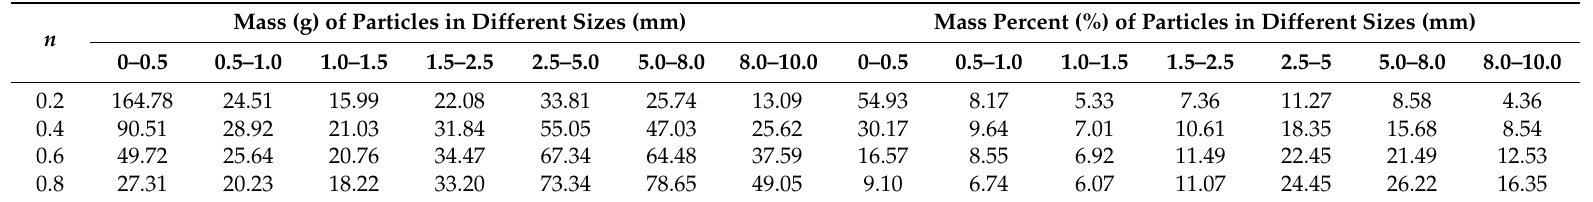
Table 2. Distribution of particles under different Talbot